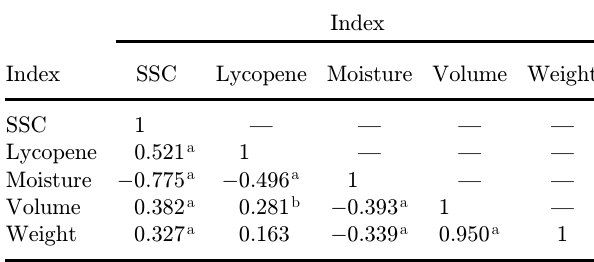
Fig. 6. The result of calibration model on volume.